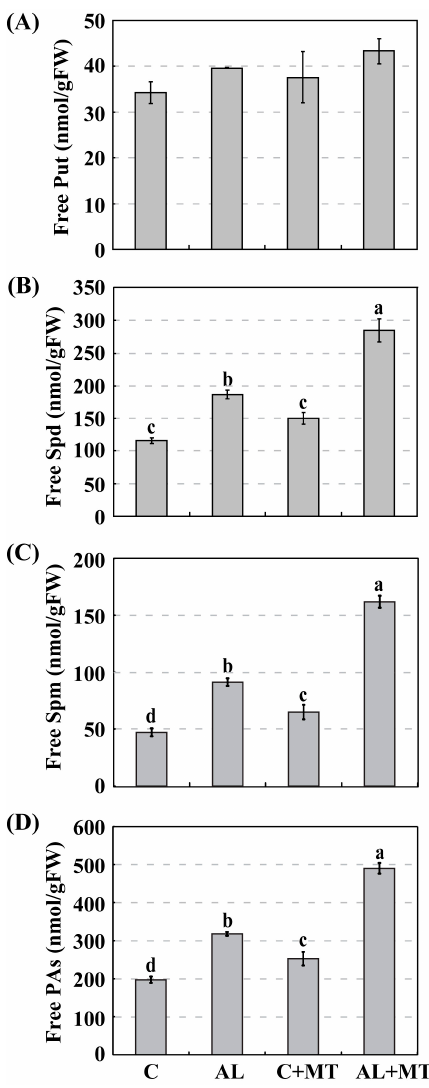
Figure 7. Accumulations of free polyamines (PAs) in Malus hupehensis Rehd. seedlings in response to alkaline stress and/or melatonin treatment. ( A ) Putrescine (Put); ( B ) Spermidine (Spd); ( C ) Spermine (Spm); ( D ) Accumulation of total free PAs. Lower-case letters indicate significant differences among treatments, based on Duncan’s multiple range test ( p < 0.05).